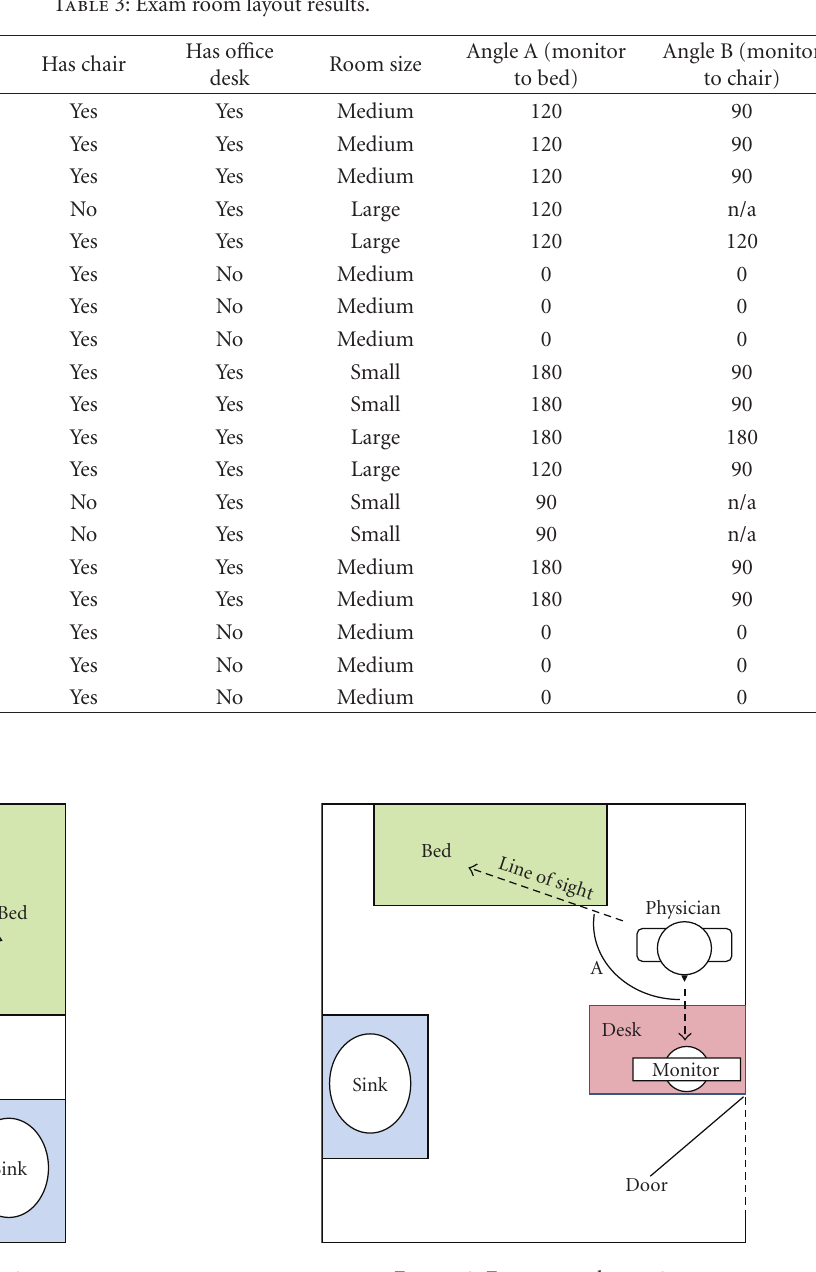
Figure 2: Exam room layout 2. Figure 3: Exam room layout